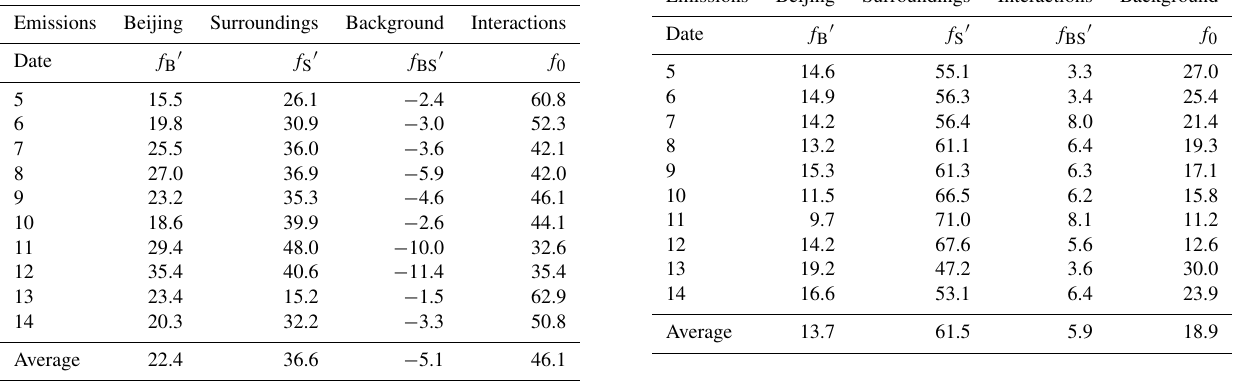
Table 4. Average PM 2 . 5 contributions (%) in Beijing from local and non-Beijing emissions, as well as the interactions of both emissions and background emissions from 5 to 14 July